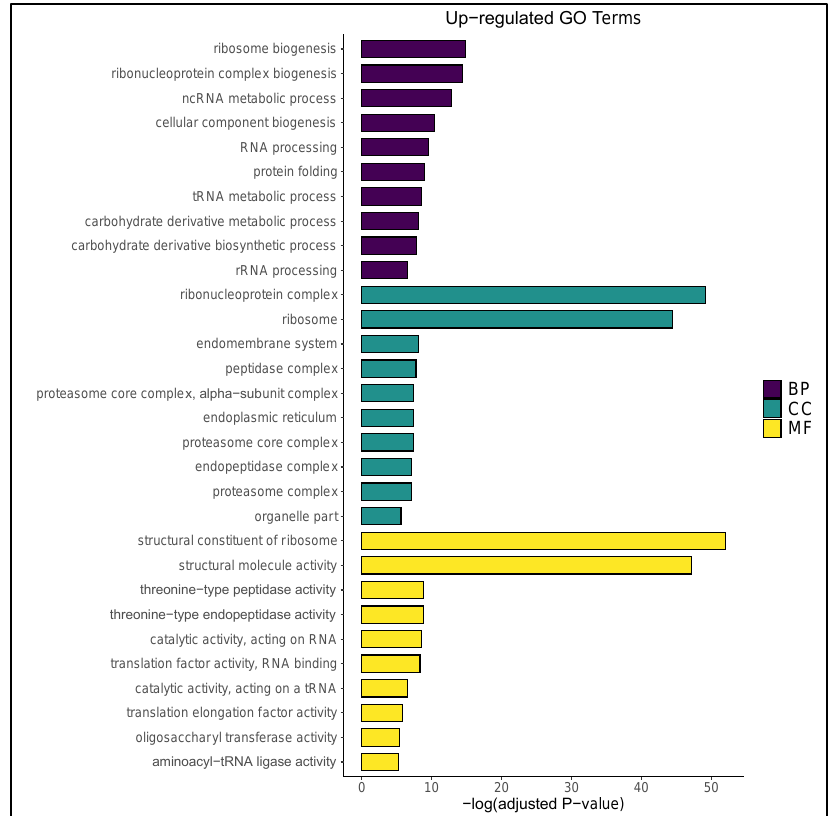
Figure 4. Upregulated GO terms in the temperature-stressed microspore population with respect to the untreated control. Statistically significant biological processes (BP), cellular components (CC), and molecular functions (MF) are ranked in descending order by adjusted p -value ( − log[adjusted p -value]). A comprehensive list of enriched GO terms is available in Supplementary File 2.